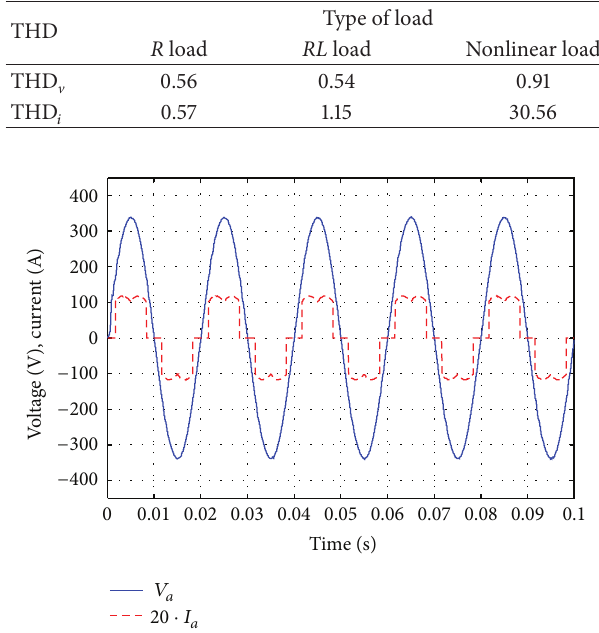
Figure 23: Output voltage (𝑉 𝑎 ) and current load (𝐼 𝑎 ) of the inverter with nonlinear load.